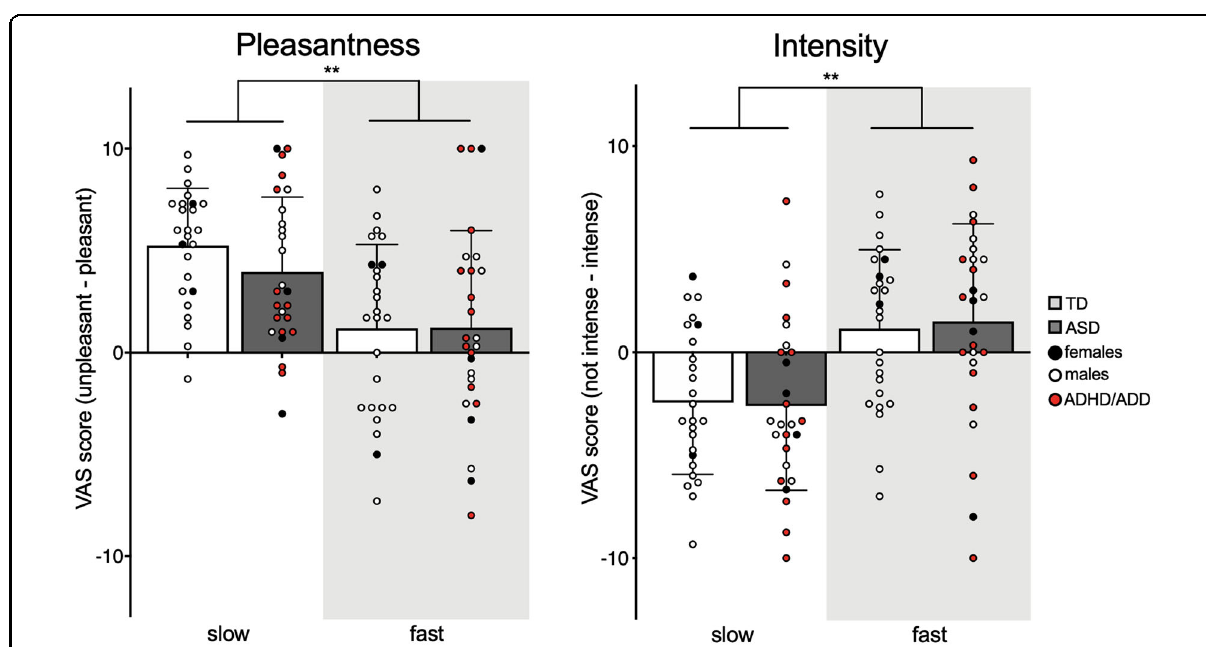
Fig. 1 Pleasantness and intensity ratings. Slow brushing was perceived as more pleasant and less intense than fast brushing in both groups [ASD ( N = 26) nd TD ( N = 25)]. Sex, ADHD/ADD and depression comorbidities and CS medication were included as covariates. **indicate p < 0.001. Error bars indicate standard error of the mean